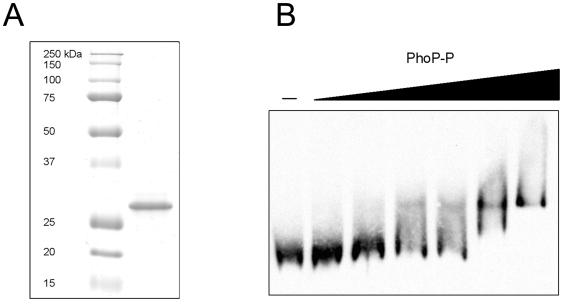
His-PhoP binds to the promoter regions of sseL.(A) 5 µg of the purified His-tagged PhoP protein was analyzed on an SDS-PAGE by Coomassie Blue staining to assess its purity. Molecular weight markers (kDa) are shown on the left. (B) Electrophoretic mobility shift assay analysis of sseL promoter. A 128-bp DNA fragment containing the putative PhoP binding sites of the sseL promoter was Dig-labeled. 15 fmol of the labeled probe was incubated at 37°C in a binding buffer containing a 100-fold excess of dI-dC as a nonspecific DNA competitor, in the presence of increasing amounts of phosphorylated His-PhoP protein (0, 12.5, 25, 50, 100, 200, 400 pmol). The PhoP-DNA mixtures were subjected to a 6% native polyacrylamide gel electrophoresis and imaged as described in Materials and Methods.